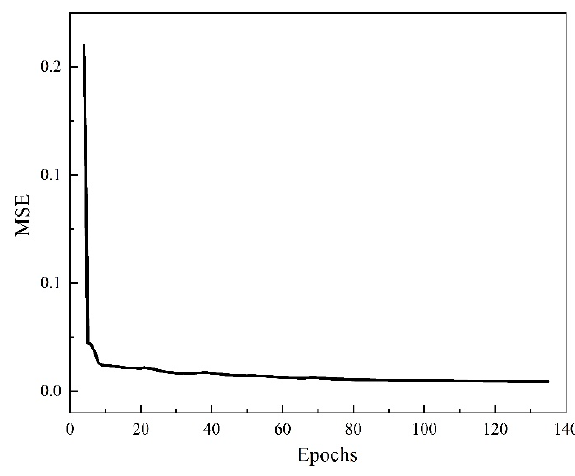
Figure 7. Loss curve of RNN-LSTM.